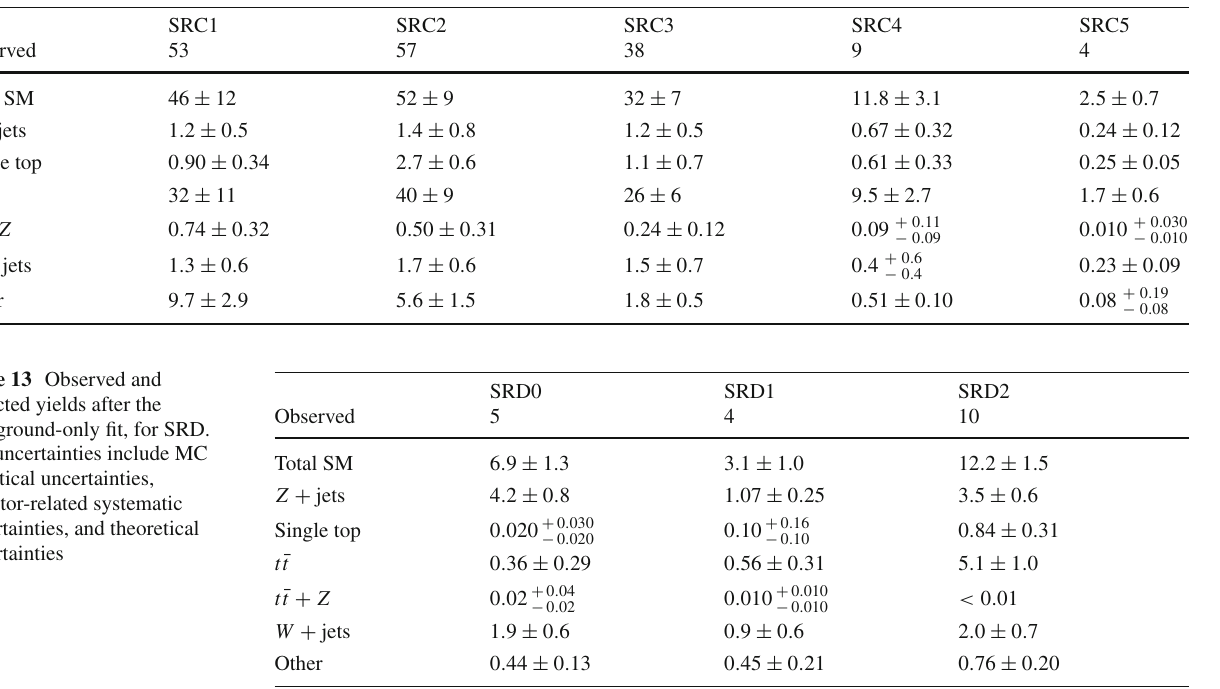
Table 12 Observed event yields in SRC compared with expected SM background yields in each signal region after the background-only fit. The uncertainties include MC statistical uncertainties, detector-related systematic uncertainties, and theoretical uncertainties